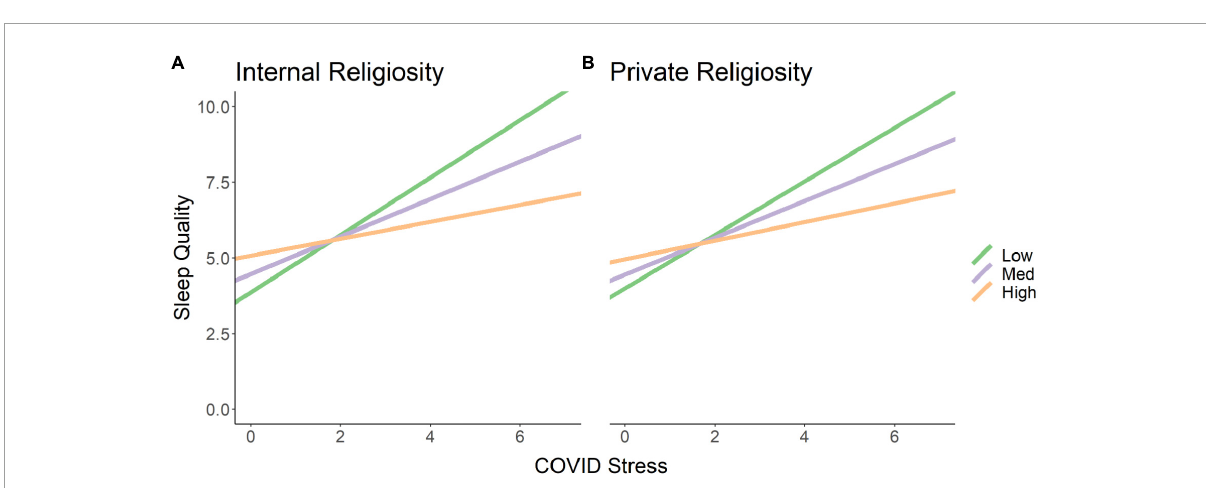
FIGURE2 High religiosity protects against the negative effects of COVID stress on sleep quality. The simple slopes represent levels of religiosity: low (1 SD below the mean, green), med (mean, purple), and high (1 SD above the mean, orange). Higher endorsement of (A) internal and (B) private religiosity attenuates the negative association between high COVID stress and poor sleep